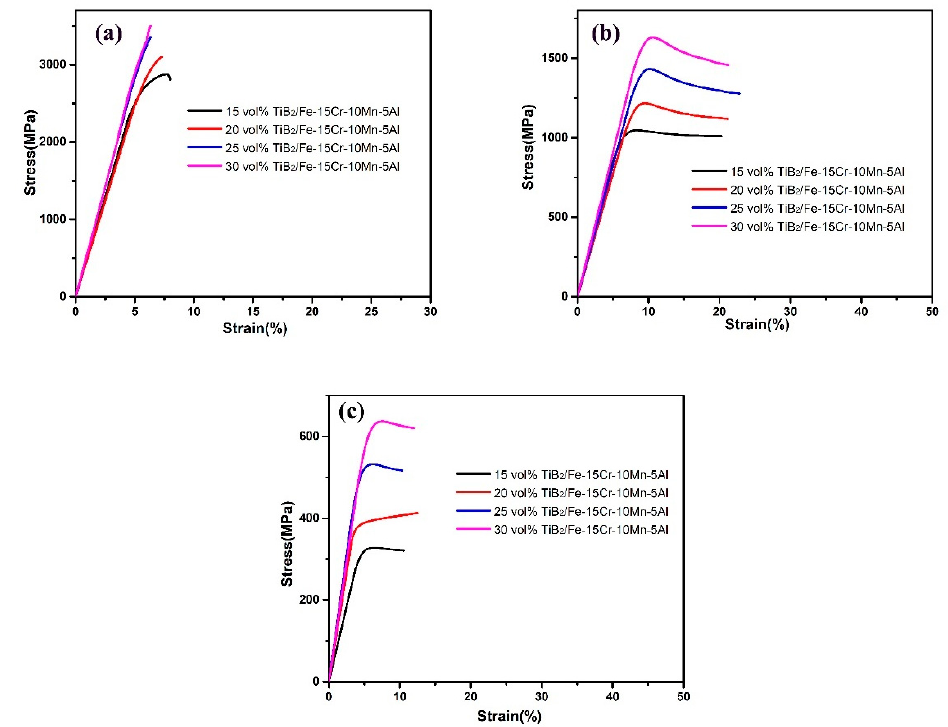
Figure 10. Compressive stress-strain curves obtained for TiB 2 /Fe-15Cr-10Mn-5Al composites with different TiB 2 at: ( a ) room temperature, ( b ) 600 °C, ( c ) 800 °C.